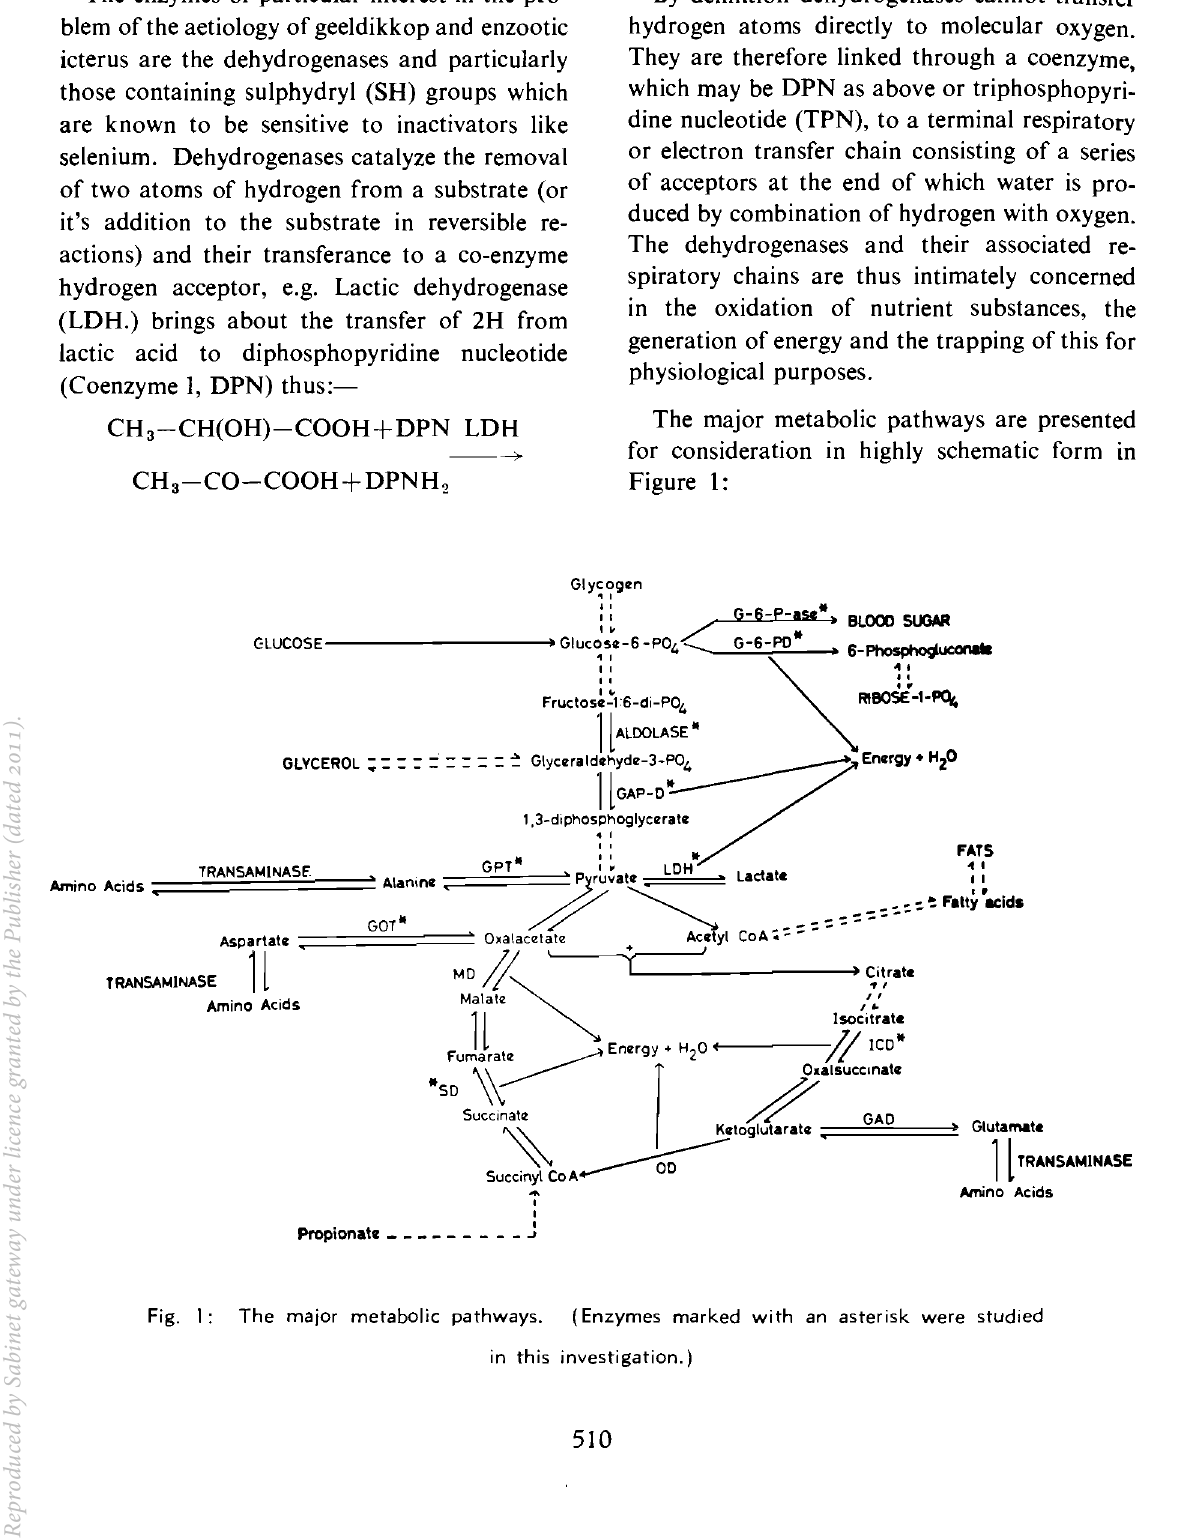
Fig. 1: The major metabolic pathways. (Enzymes marked with an asterisk were studied in this investigation.)